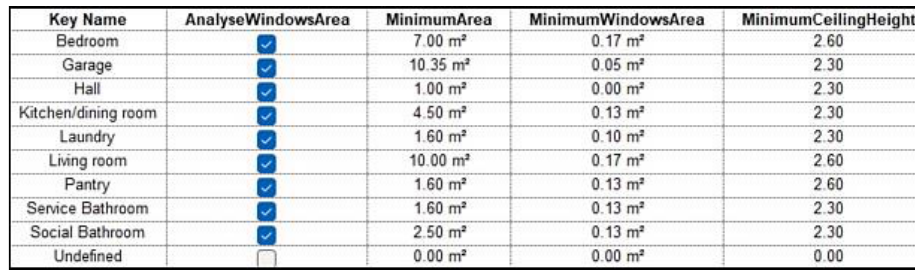
Figure 7. MF building window and room schedule.